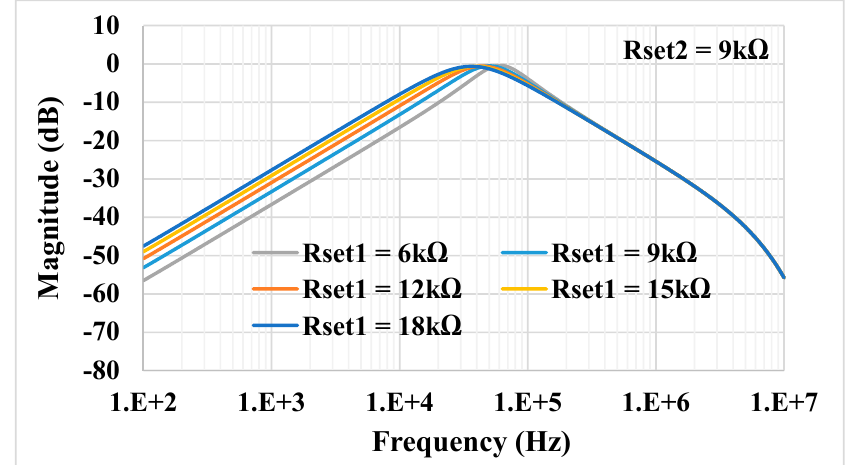
Figure 12. Tunability of the BP filter for different R set1 and the constant R set2 .